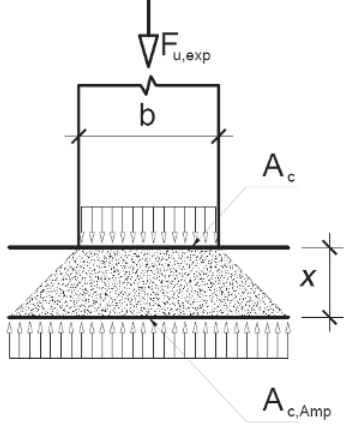
Figura 6 Área ampliada A